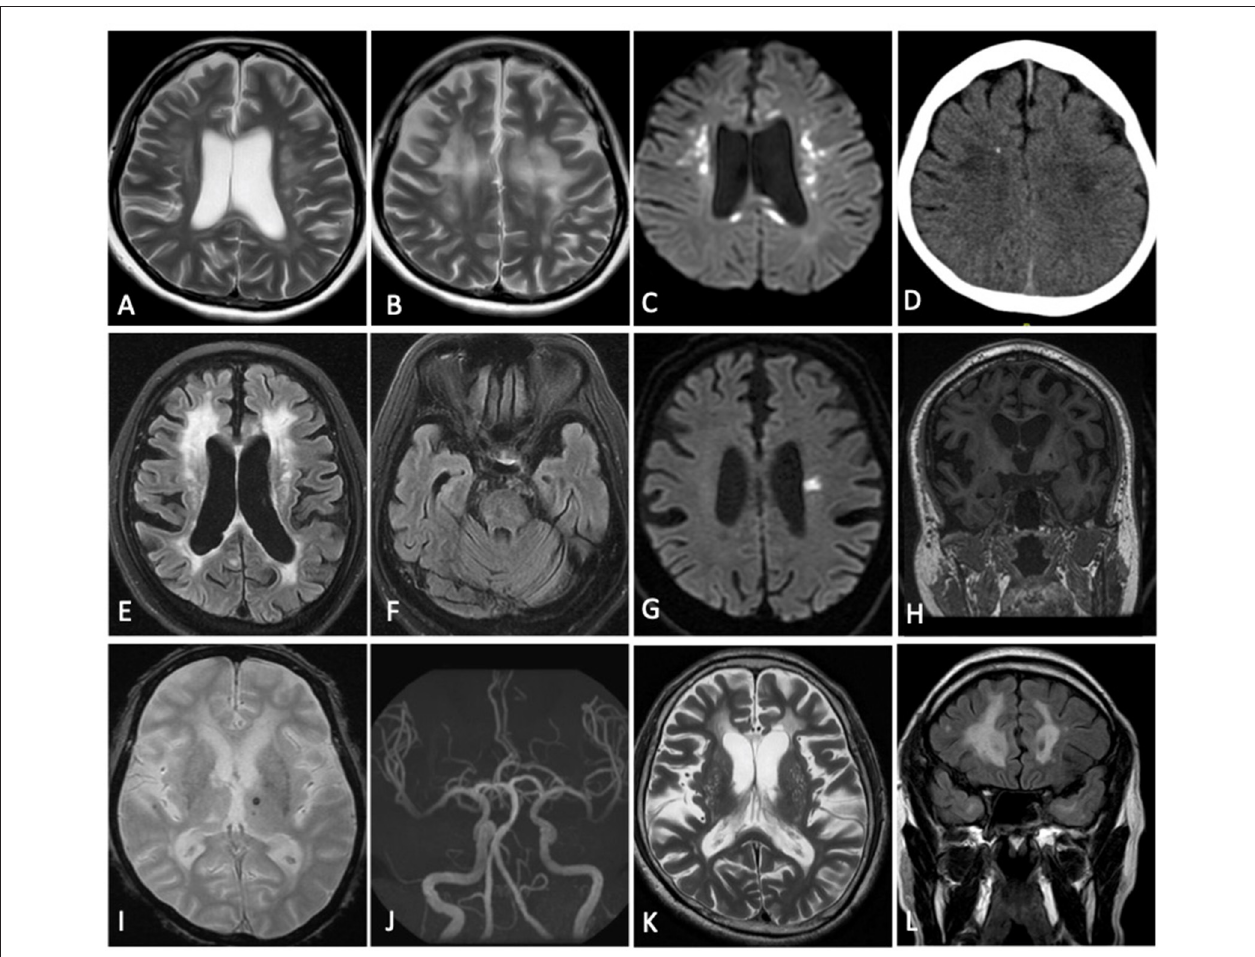
FIGURE 2 | Imaging findings of patients with specific diagnoses. Patient with frontal predominant MRI pattern secondary to CSF1R-related leukoencephalopathy (A–D) : confluent frontal predominant white matter changes (A,B) associated with scattered areas of restricted diffusion (C) and an area of intraparenchymal calcification (D) . Patient with multifocal MRI pattern consistent with VCI-SVD secondary to heterozygous mutation of HTRA1 (CADASIL2) (E–K) : multifocal white matter hyperintensity (E) without involvement of the anterior temporal poles (F) , acute (G) and chronic (H) lacunar infarcts, microbleeds (I) , normal intracranial vasculature (J) with dilated perivascular spaces (K) . Patient with multifocal MRI pattern consistent with VCI-SVD secondary to heterozygous mutation of NOTCH3 (CADASIL1) (L) : multifocal white matter hyperintensity with involvement of the anterior temporal poles (L) . (A,B,K) Axial T2; (C,G) Axial DWI; (D) Axial CT Brain;